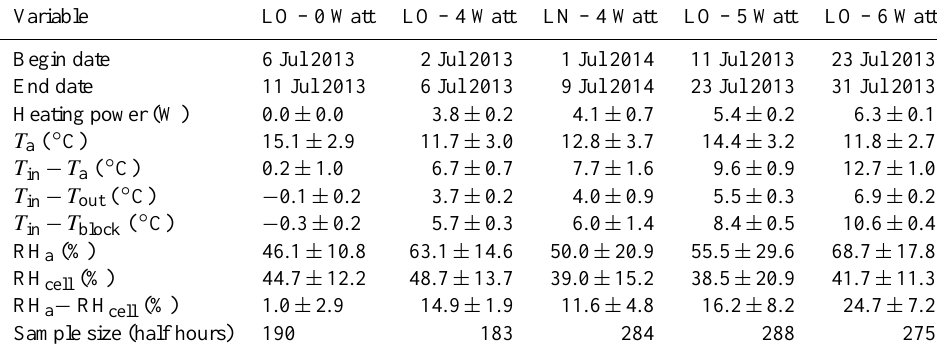
Table 4. Descriptive statistics (median and median absolute deviation) covering periods of different heating settings of the LI-7200 intake tube and filter. The header distinguishes combinations of different rain caps (LO, LN) and heater settings (0, 4, 5, 6Watt). Ambient temperature ( T a ), LI-7200 inlet temperature ( T in ), LI-7200 outlet temperature ( T out ), LI-7200 block temperature ( T block ), ambient relative humidity (RH a ) and LI-7200 cell relative humidity (RH cell ) are